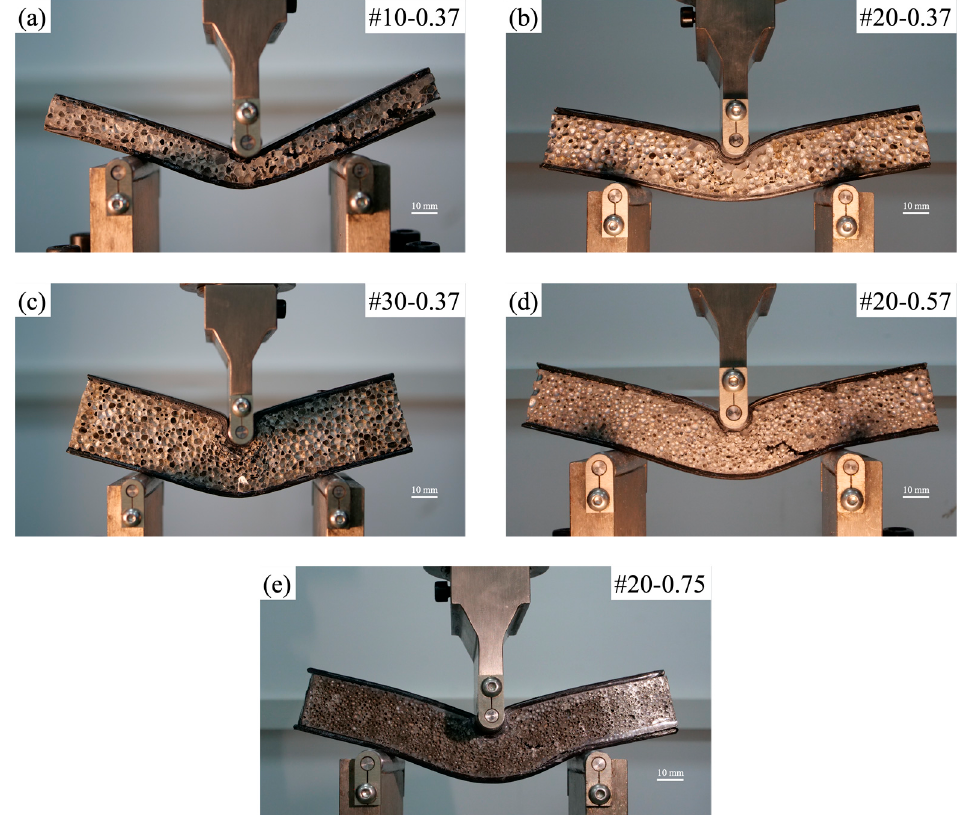
Figure 7. Deformation modes of specimens in three-point bending: ( a ) #10-0.37; ( b ) #20-0.37; ( c ) #30- 0.37; ( d ) #20-0.57; ( e ) #20-0.75.